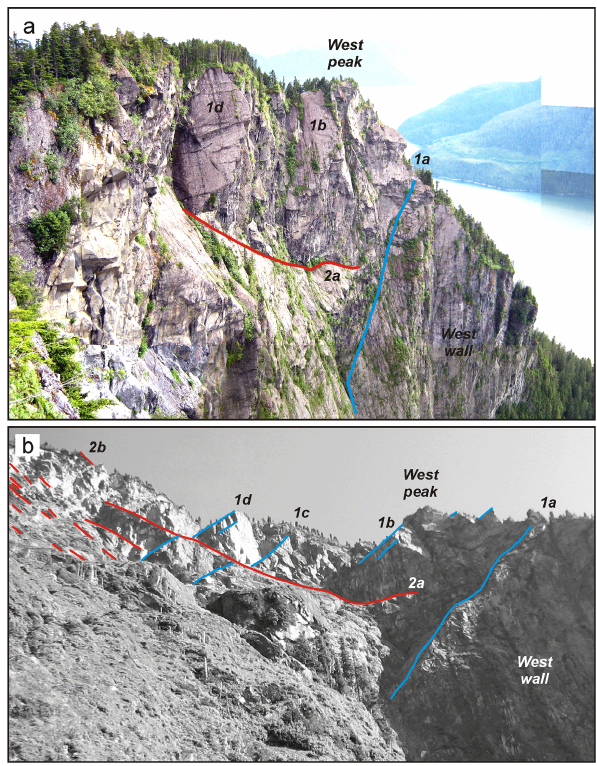
Figure 8. Oblique photographs showing major structures at the crest of the rock slope. See text for explanation of discontinuity